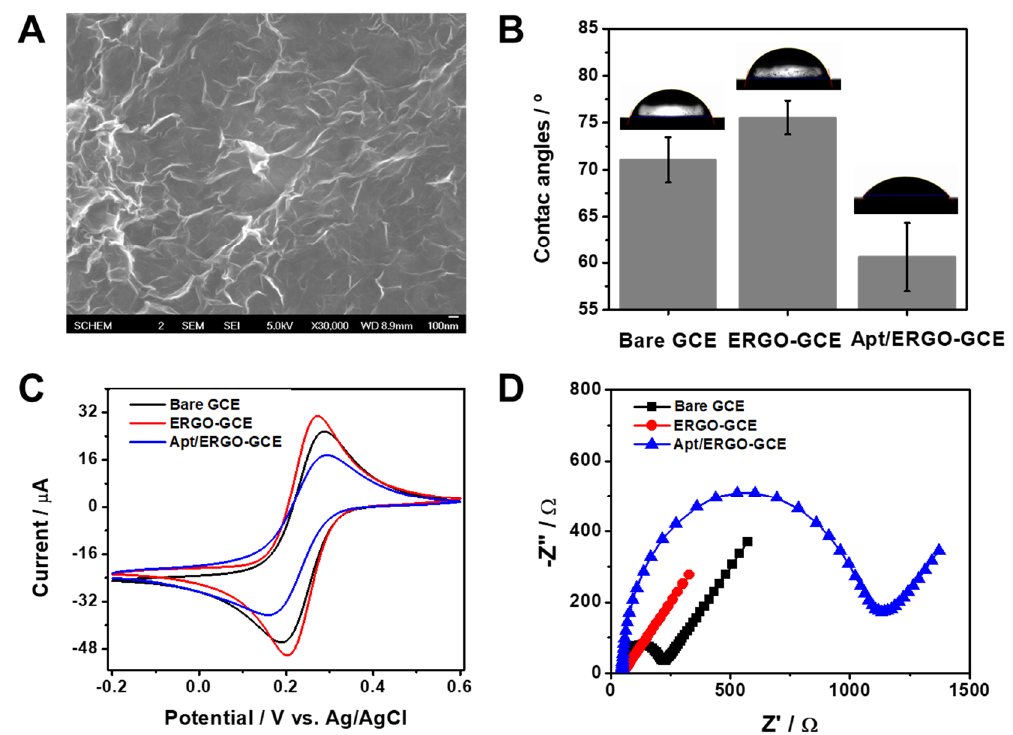
Figure 1. ( A ) Scanning electron microscopy (SEM) image of ERGO-GCE. ( B ) Contact angle data of water droplets on GCE, ERGO-GCE, and Apt/ERGO-GCE. ( C ) Cyclic voltammetry (CV) curves recorded at a scan rate of 10 mV·s −1 and ( D ) Nyquist plots of GCE, ERGO-GCE, and Apt/ERGO-GCE in 0.1 M tris-buffered saline (TBS) buffer containing 5.0 mM [Fe(CN) 6 ] 3− .